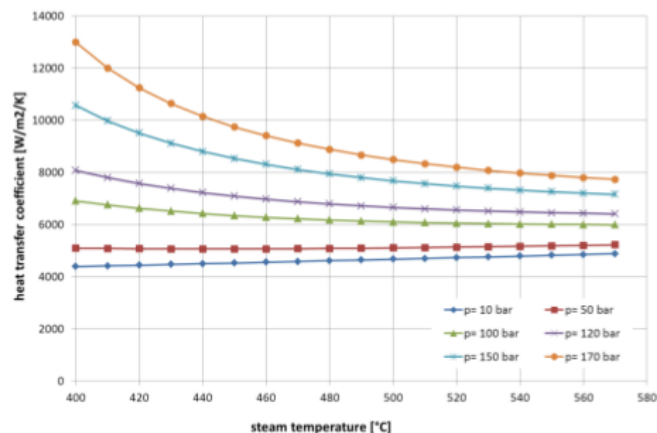
Figure 5: Heat transfer coefficient for surface after first HP stage.